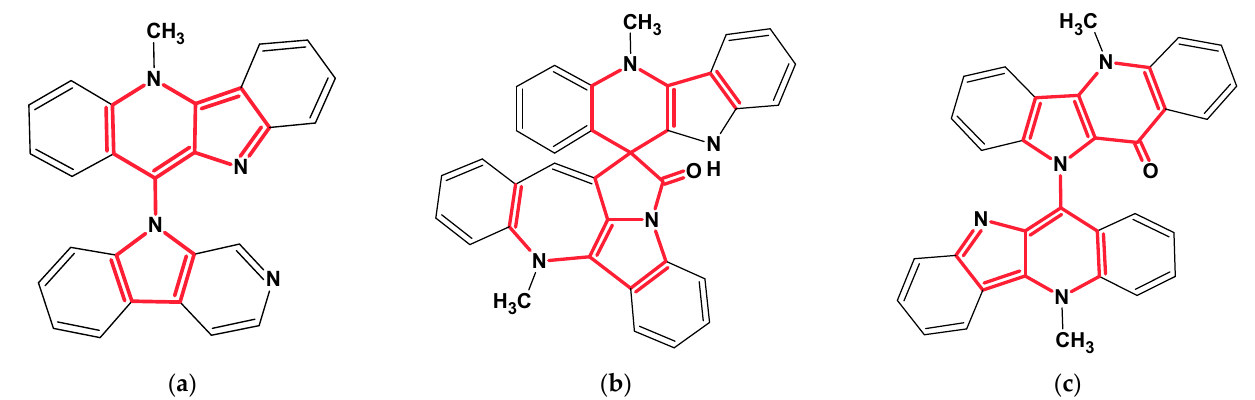
Figure 13. Challenging structures ( a – c ) that could not be elucidated using either the Common or Fragment Modes.